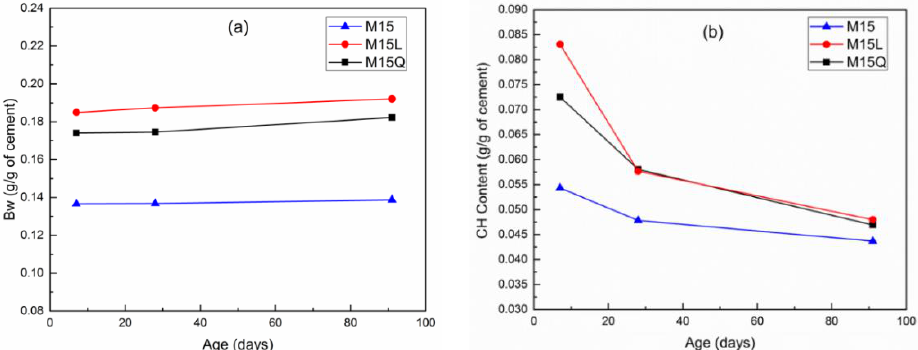
Figure 5. Development of bound water content ( a ) and calcium hydroxide content ( b ) between 7 and 91 days for mixtures M15, M15L and M15Q. 91 days for mixtures M15, M15L and